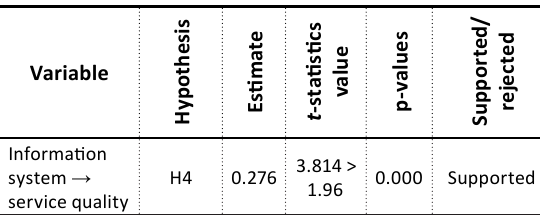
Table 4. Path coefficient for information systems and service quality